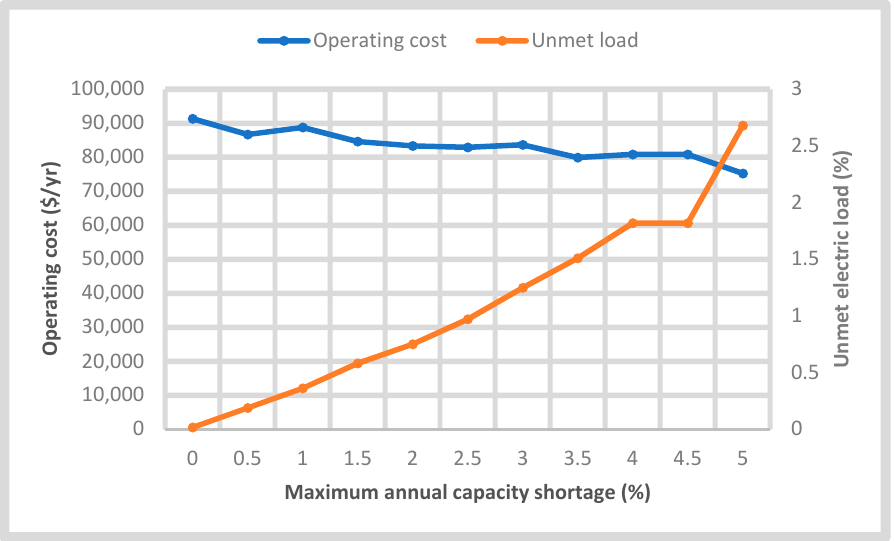
Figure 18. Effect of increasing the maximum annual capacity shortage on the operating cost and unserved electric load.